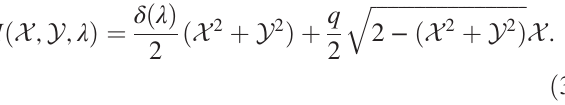
FIG. 1. Phase-space portraits of the Hamiltonian (23) for q ¼ 1 and δ ¼ 1 (top), δ ¼ 0 (center), and δ ¼ − 1 (bottom) in three different representations: action-angle coordinates ð ϕ ; J Þ on the left column, Cartesian coordinates ð X ¼ central column, and on a spherical surface (as described in Sec. II B) on the right column, where the coordinate ϕ is the polar angle while the azimuthal angle is given by θ ¼ asin ð 2 J − 1 Þ . The red line represents the critical curve (the so-called coupling arc in Refs. [17,22]). The plots on the left column are the equirectangular projections of the spherical surface, the poles being represented by the J ¼ 0 and J ¼ 1 lines while the plots on the central column are the azimuthal representations centered around the south pole. Note that the artificially large value of q , together with large values of δ and of J , is used to make more visible the key features of the phase-space